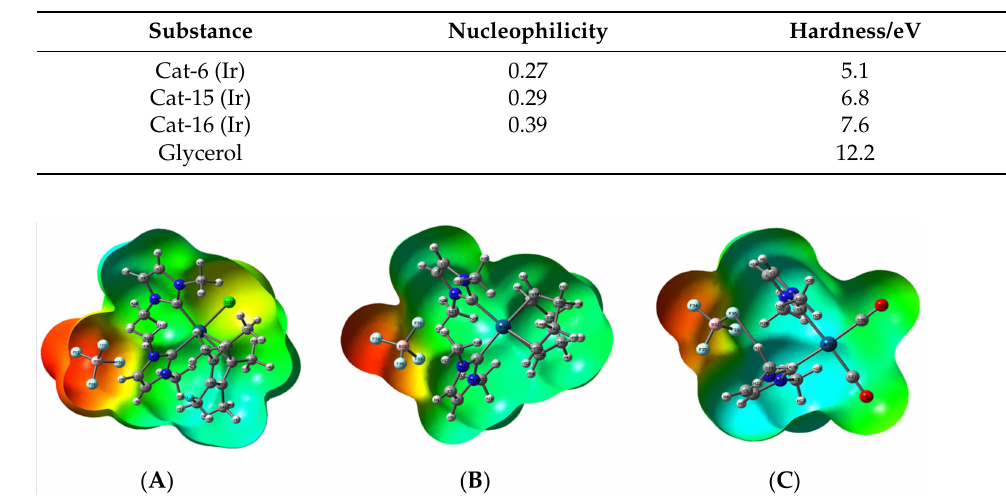
Table 1. The hardness and nucleophilicity of cat-6, cat-15, and cat-16 (hardness refers to small, highly charged states with low polarizability).